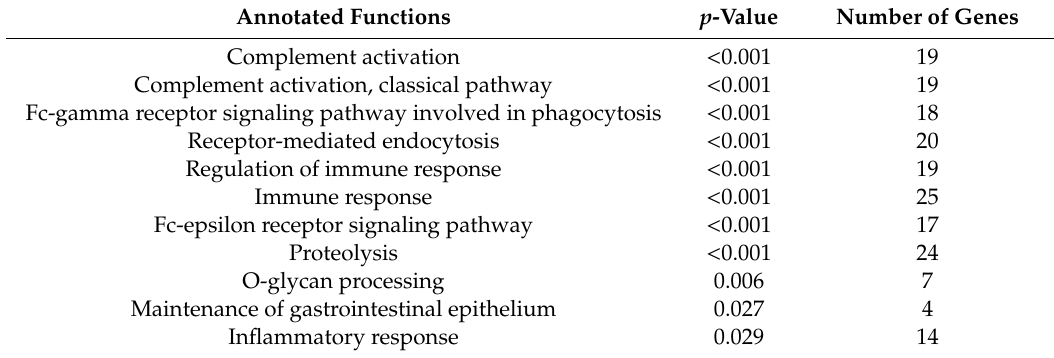
Table 1. Significantly enriched Gene Ontology (GO) terms in non-organoid-forming